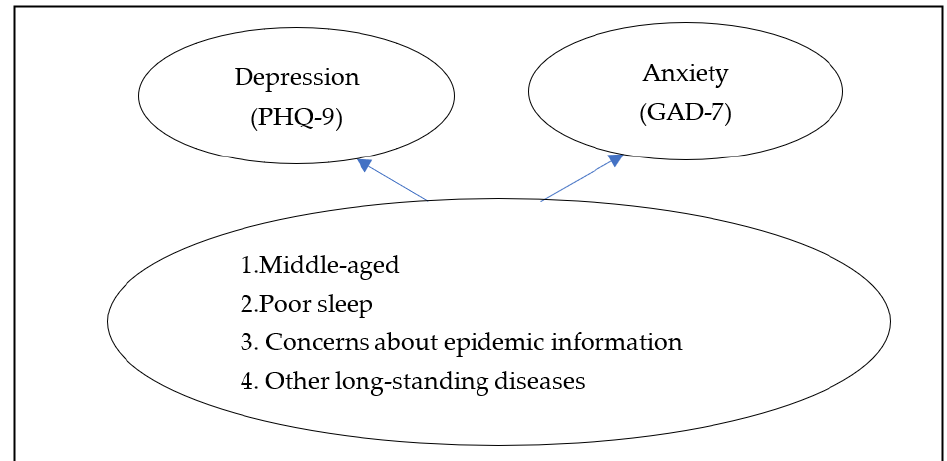
Figure 1. Theoretical Framework.